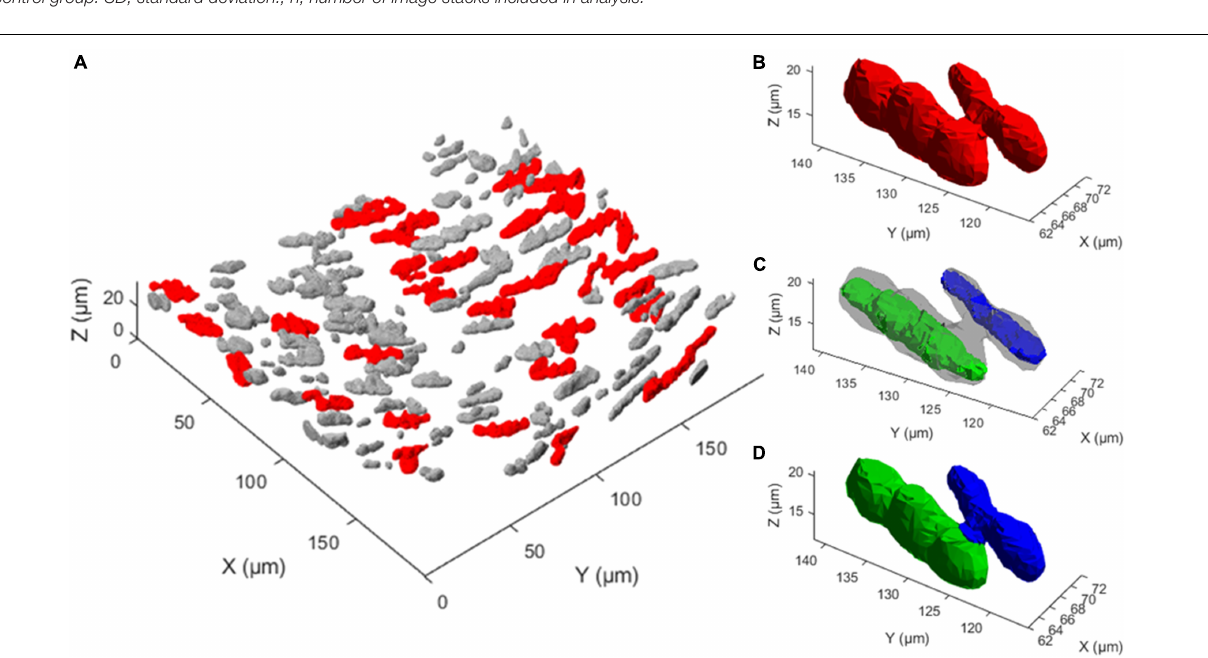
FIGURE 7 | Multi-nucleus structure splitting is required for accurate nucleus quantification. (A) 3D rendering of the extracted nucleus structures from one 3D fluorescence image. Gray structures were deemed a single nucleus by the nuclear splitting procedure, while red structures were deemed to consist of multiple nuclei, illustrating how frequently multiple nucleus structures appear. (B) A single extracted structure, shown in red, that visually consists of two touching nuclei. (C) Two nucleus cores, shown in green and blue, are the result of the first two steps of the nuclear spitting procedure on the structure shown in (B) . (D) Result of the nuclear splitting procedure, where the structure in panel B has been separated into two structures, indicated in green and